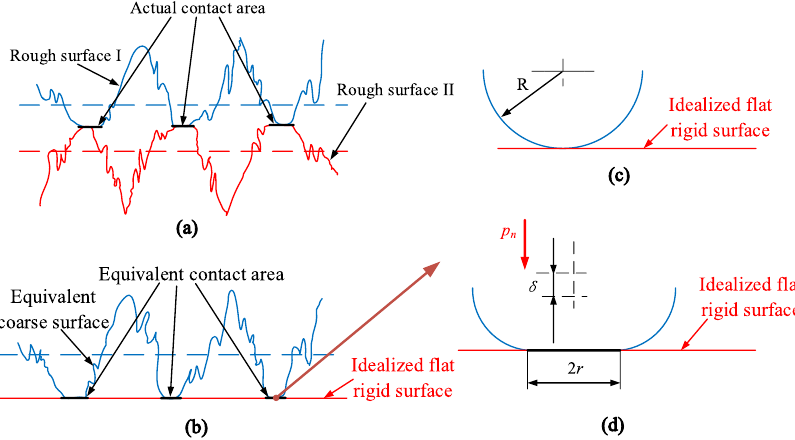
Figure 3. Schematic diagram of contact interfaces: ( a ) actual contact interface; ( b ) equivalent contact interface; ( c ) equivalent contact interface between a sphere asperity and a smooth surface, without zero applied load; ( d ) equivalent contact interface between a sphere asperity and a smooth surface, without applied load of p n